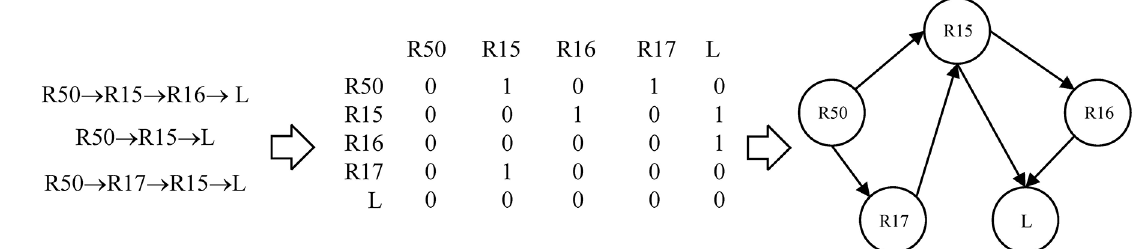
Figure 2. Formative process of a part of cost overrun risk propagation network